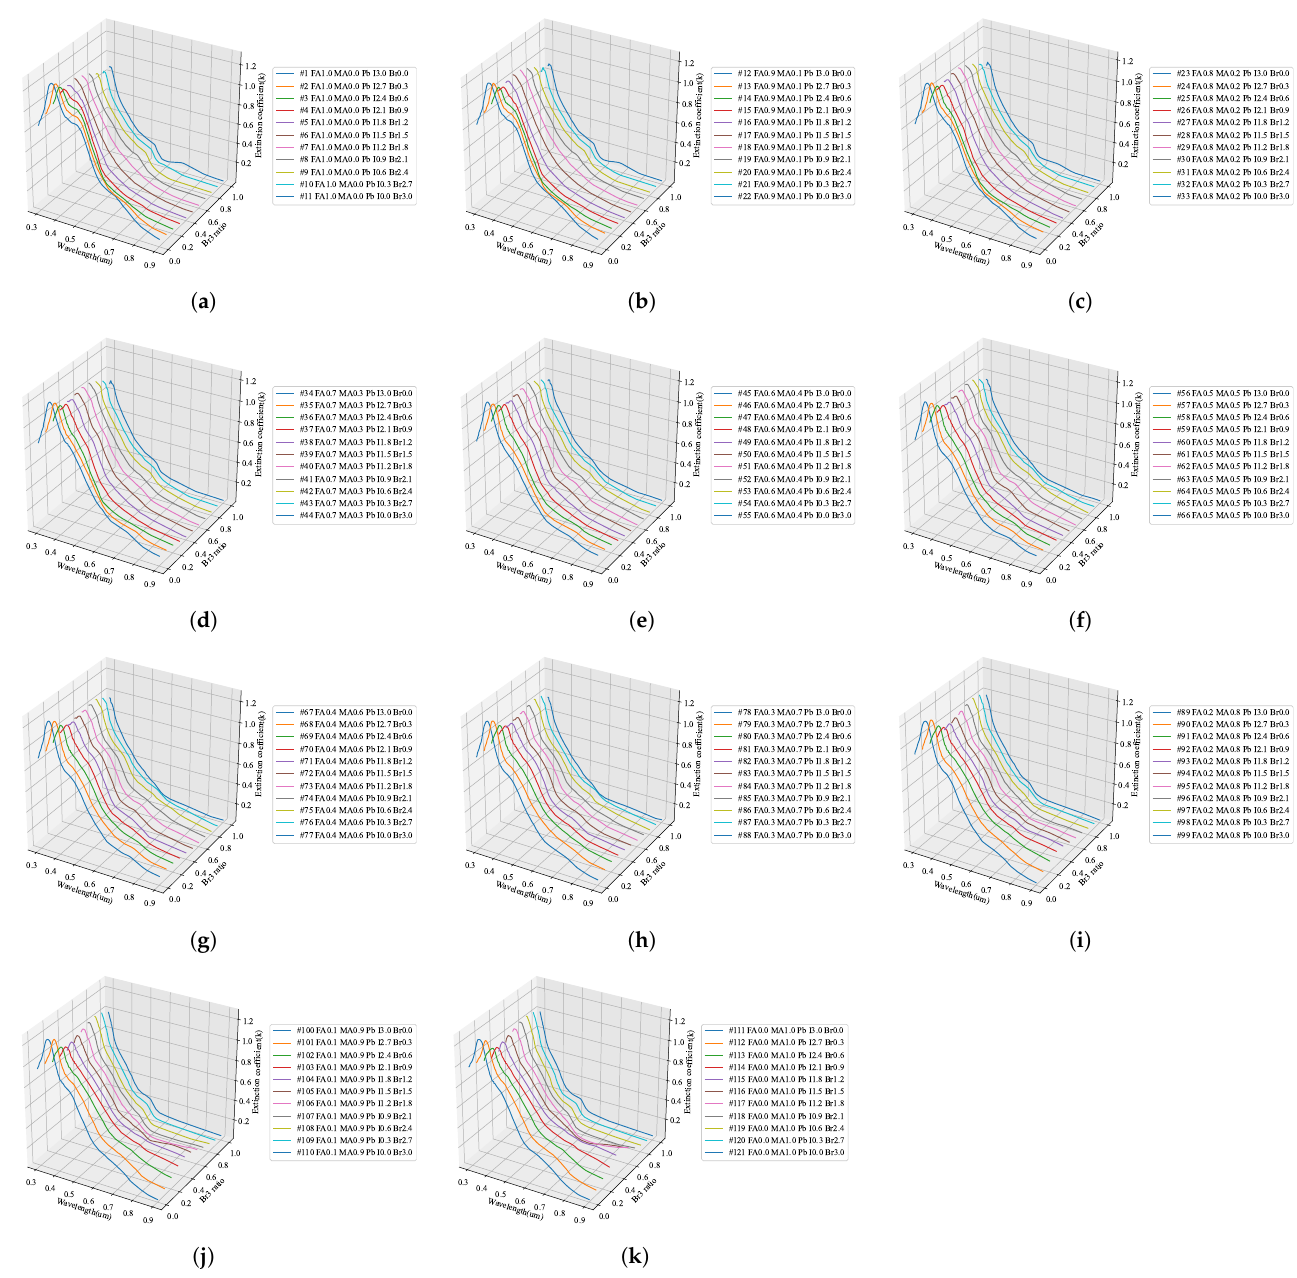
Figure 13. Predictionresult of the extinction coefficient spectrum pattern according to the stoichio- metric ratio in the direction of increasing Br 3 composition of quaternary perovskite using hyper- regression analysis with artificial intelligence: ( a ) FA 1 MA 0 PbI 3